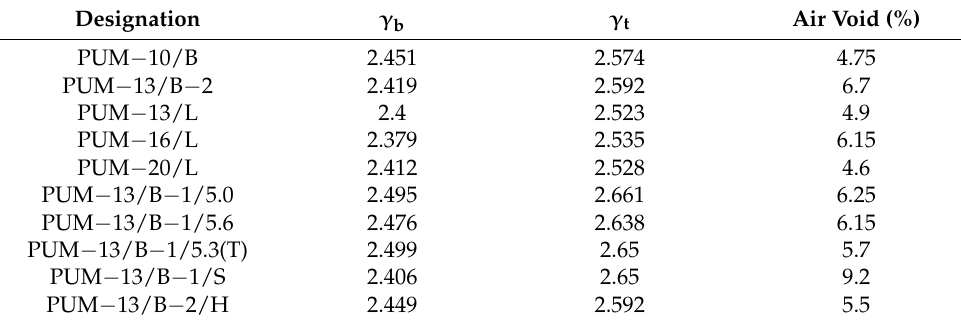
Table 3. The volume index results of the core